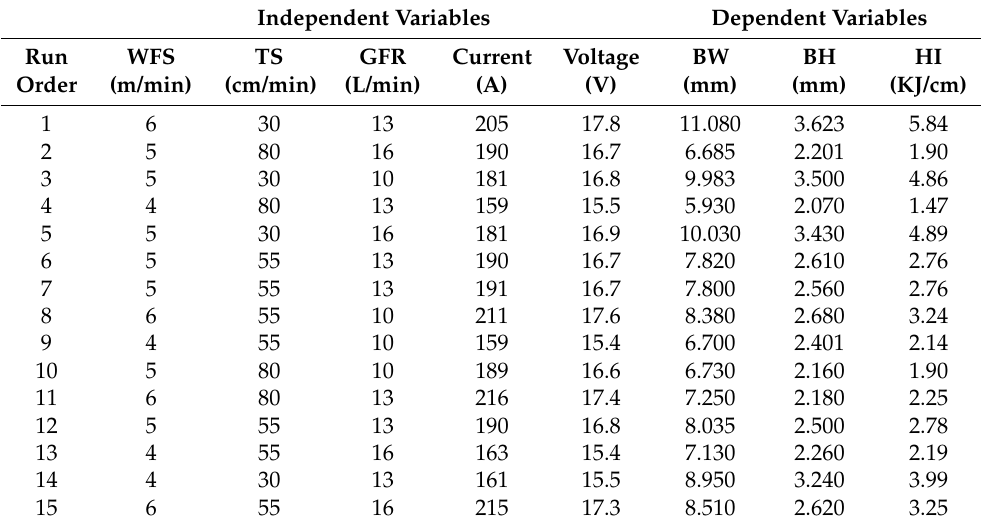
Table 3. The experimental design and measured data corresponding to each run formed by the CMT—based WAAM